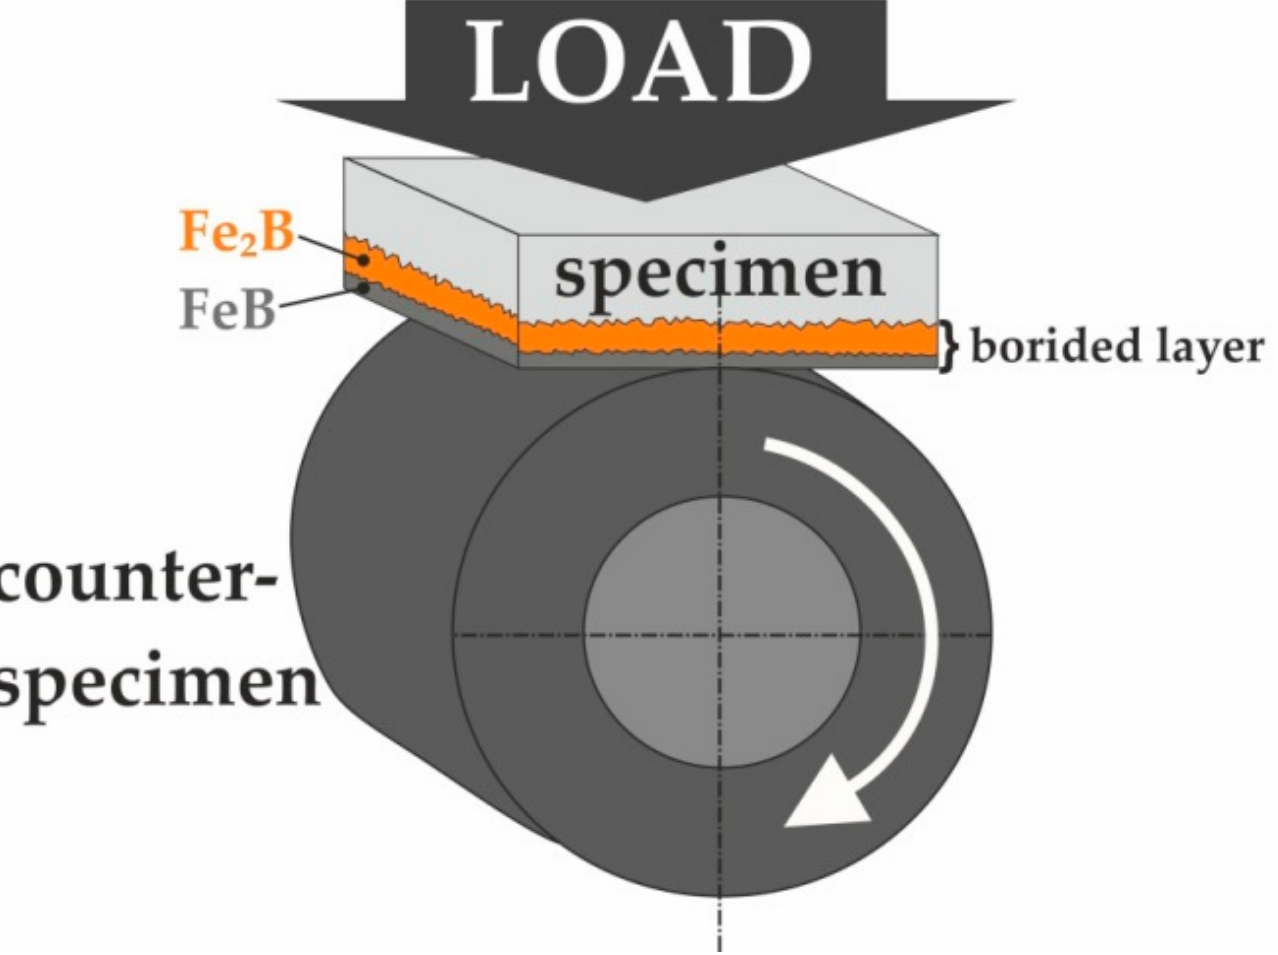
Figure 2. Scheme of the frictional pair during wear tests of powder-pack borided and non-borided X165CrV12 cold work tool steel; load F = 49 N, n = 250 min − 1 .